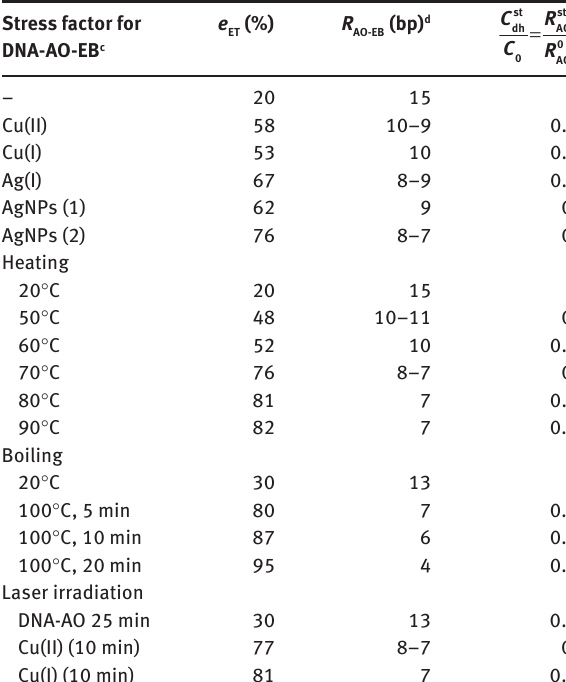
Table 5 Cu(II), Cu(I), Ag(I) ions, AgNP, laser irradiation ( λ = 457 nm),